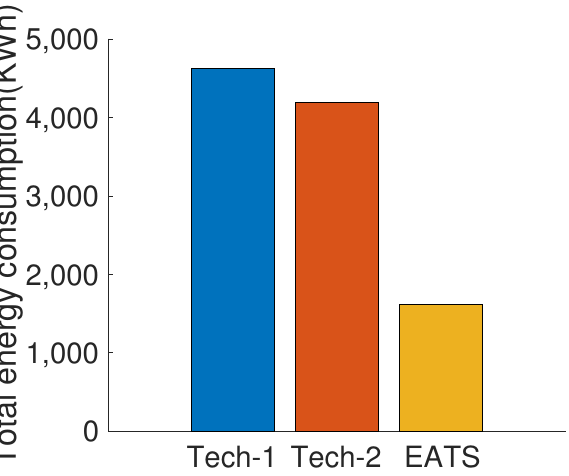
Figure 7. Comparison of data center energy consumption for Alibaba cluster data.